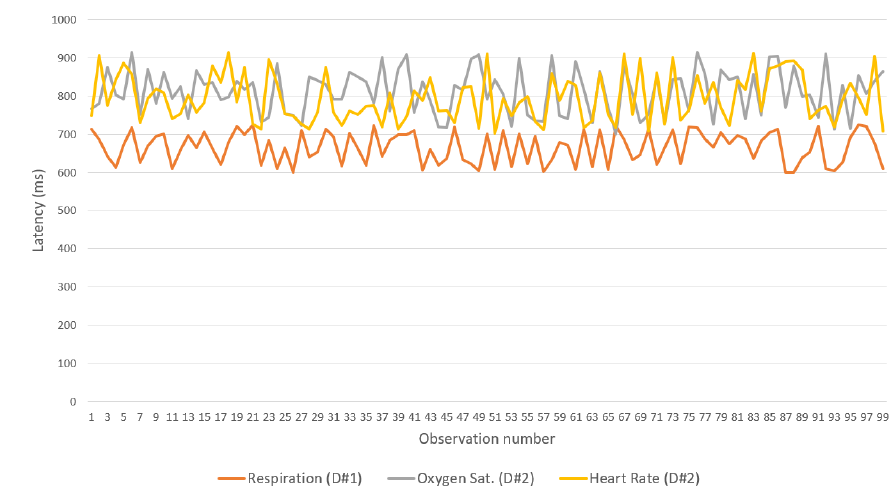
Figure 16. Latencies in the use of MQTT over Wi-Fi (IoMT devices-gateway).